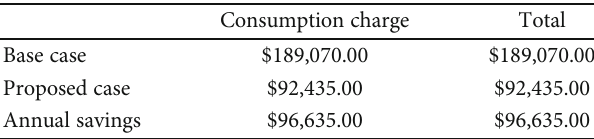
Figure 12: Monthly utility bills for the current and proposed systems for Uganda. Table 2: Annual utility bills and savings by